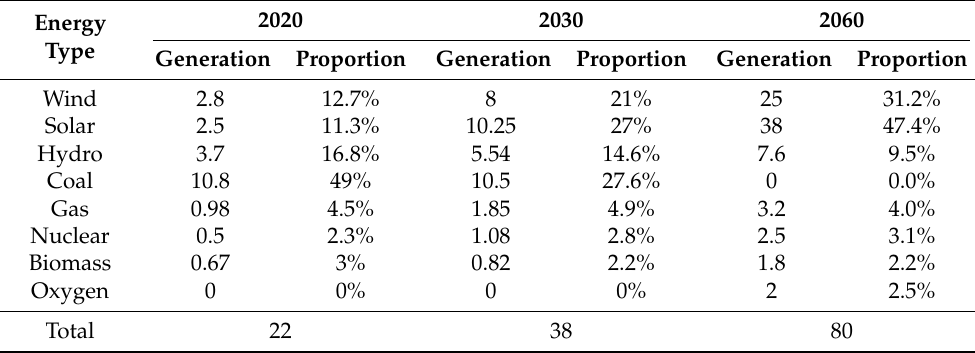
Table 3. Installed power generation and structure in China from 2020 to 2060 (in 100 million kWh). Energy